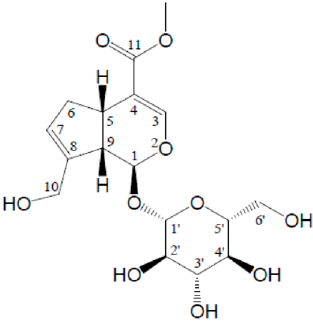
Figure 1. Chemical structure of geniposide.